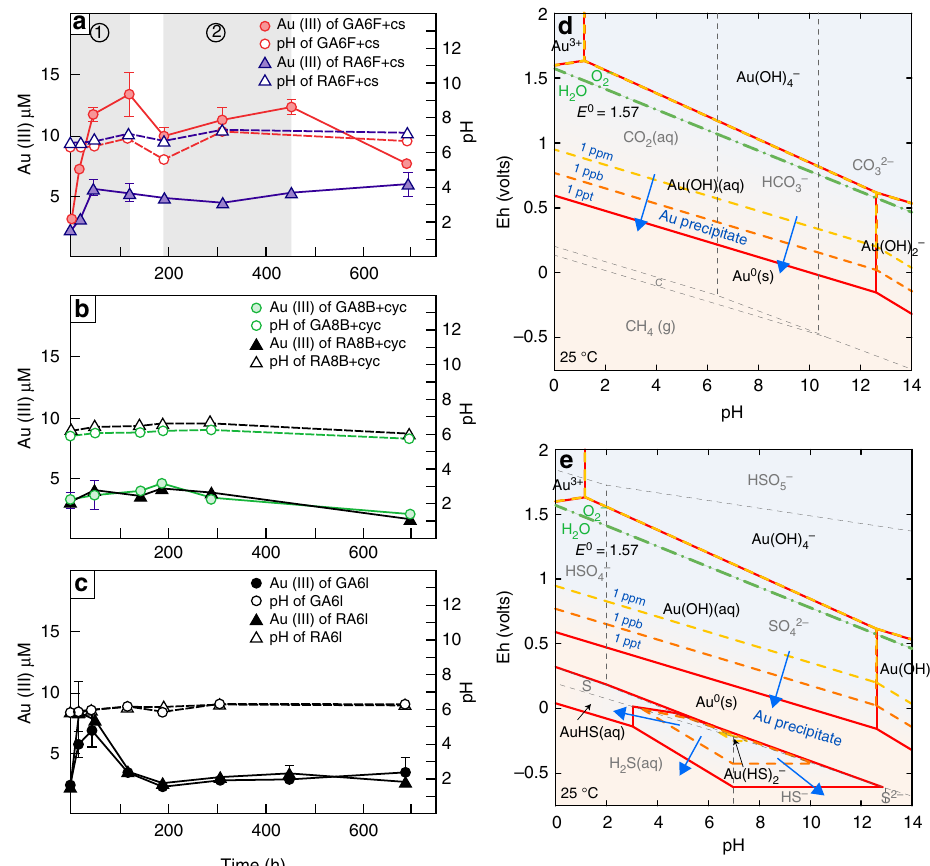
Fig. 2 Microbial gold oxidation potential and geochemical modeling in soil microcosms. a – c Time-dependence between Au(III) concentration and pH in different microcosms expressed as means of triplicates ± standard deviation. a Gold oxidation in fungal microcosms GA6F + cs and RA6F + cs, with ① and ② marking the fi rst and second linear phases of gold oxidation in microcosm GA6F + cs. b Bacterial microcosms GA8B + cyc and RA8B + cyc. c Sterilized microcosms GA6I and RA6I. d , e Geochemical models showing predominant Au speciation as a function of pH-Eh at 25 °C. The systems contain initial Au + activity of 10 − 6 to 10 − 12 , and HCO 3 - activity of 0.01 ( d ) or S 2 O 3 2- activity of 0.01 ( e ). The carbon and sulfur species are reacted with the axis species, and the dashed gray lines show the boundary of predominant carbon and sulfur species over pH-Eh conditions. Predominant Au speciation at 1 part per trillion (ppt) (solid red line), 1 part per billion (ppb) (dashed orange line), and 1 part per million (ppm) (dashed yellow line) is indicated. Blue arrows show the direction of gold